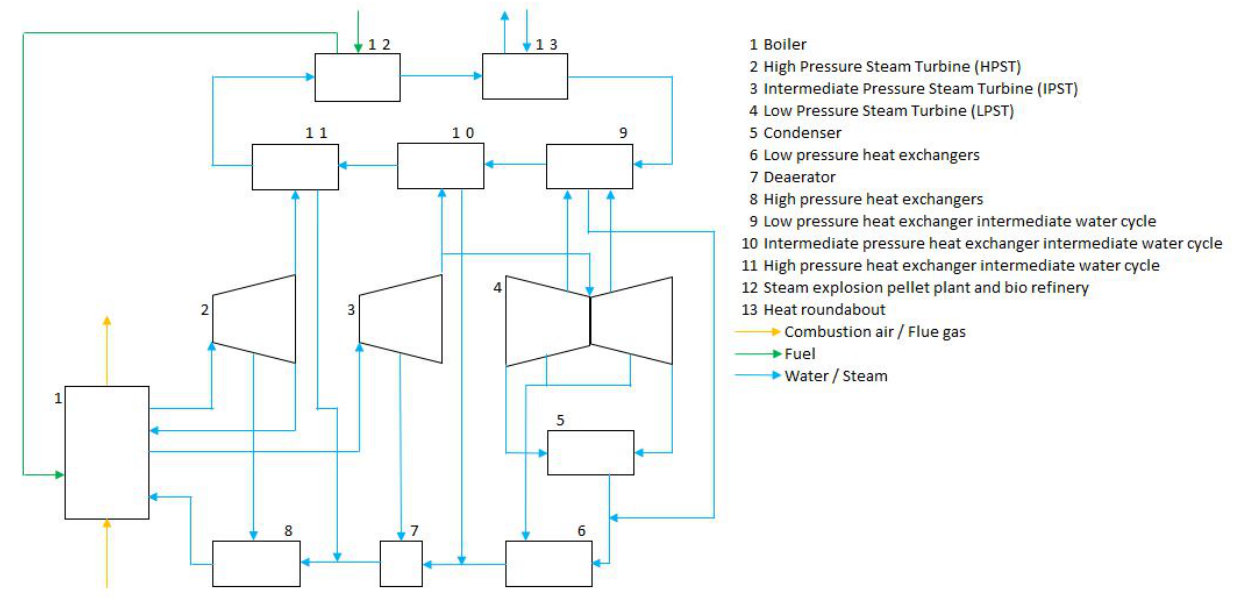
Figure 1. Overview